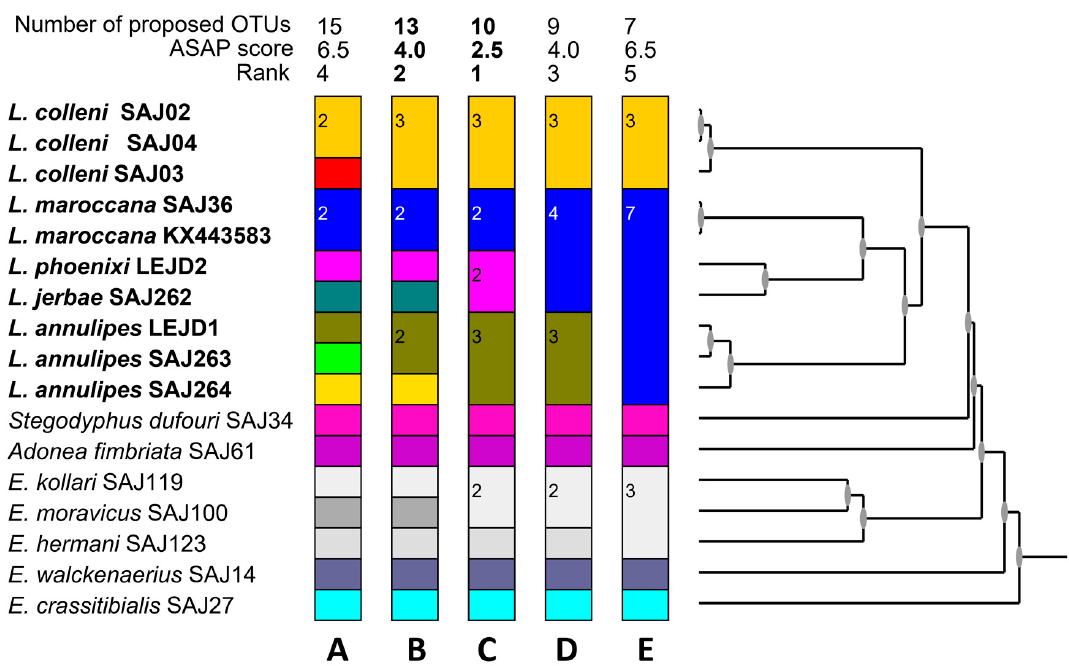
Figure 16. Result of the species delimitation analysis performed by ASAP. ( A ) 15 taxa grouping, with ASAP score 6.5; ( B ) 13 taxa grouping, with ASAP score 4.0; ( C ) 10 taxa grouping, with ASAP score 2.5; ( D ) 9 taxa grouping, with ASAP score 4.5; ( E ) 7 taxa grouping ( Loureedia would have only two species) grouping, with ASAP score 6.5. Different colors correspond to recognized species.